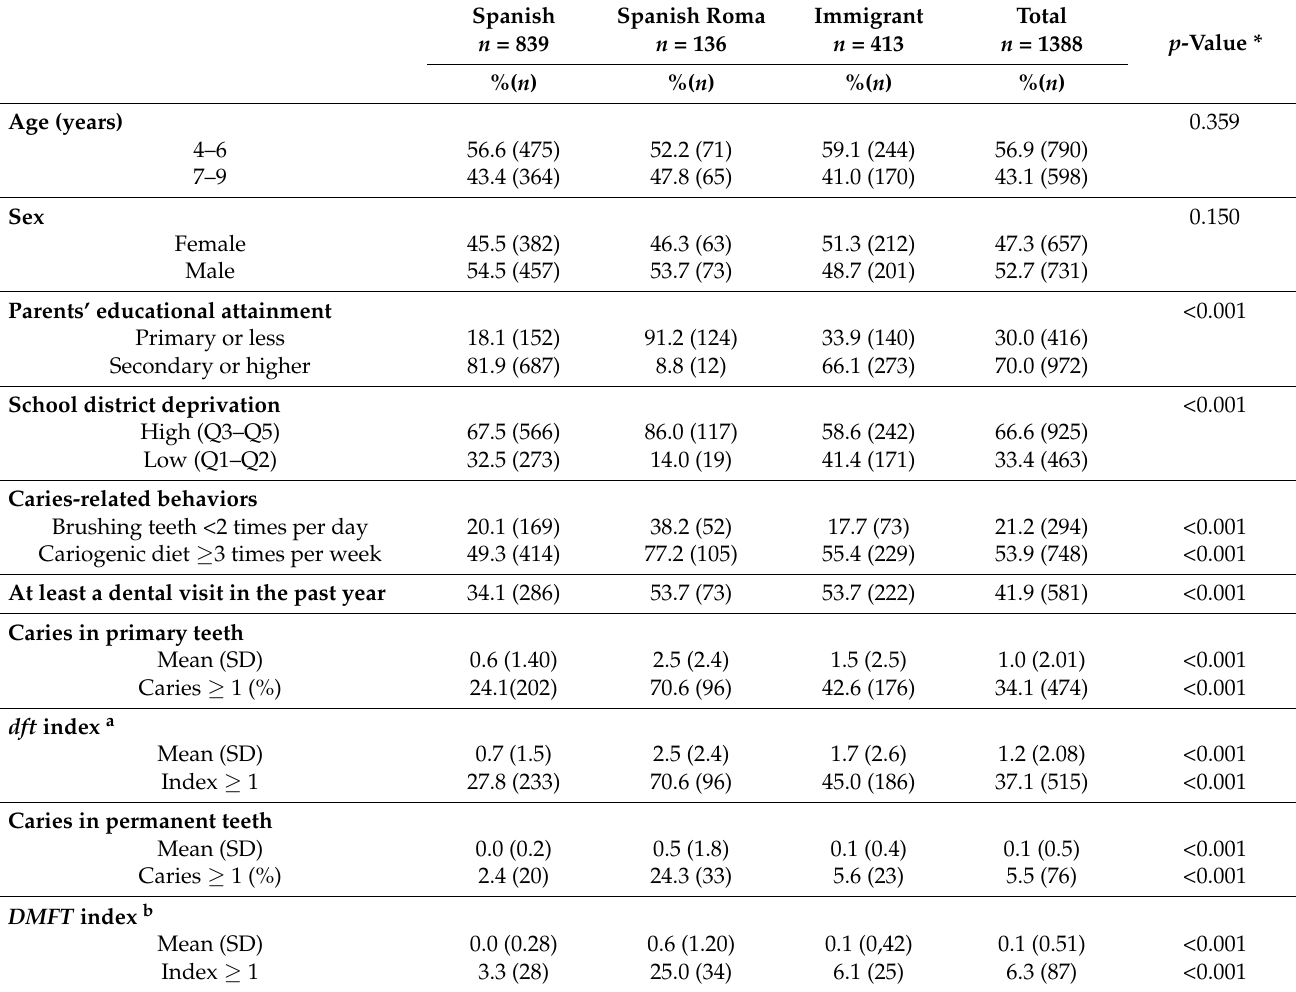
Table 1. Distribution of selected characteristics for participants according to parental migratory status/ethnicity: Children’s Oral Health Survey, Municipality of Bilbao,